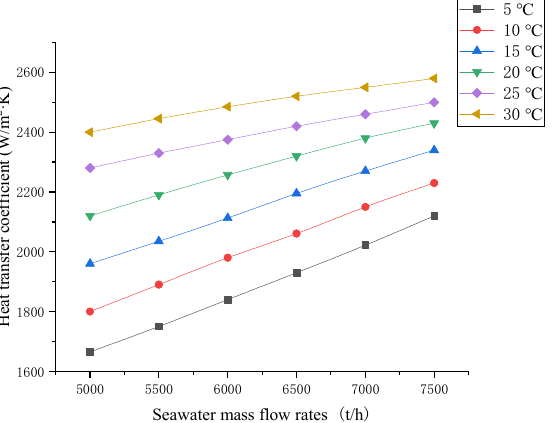
Figure 5. Surface heat transfer coefficient of the shell side under different seawater inlet temperatures and seawater flow rates.